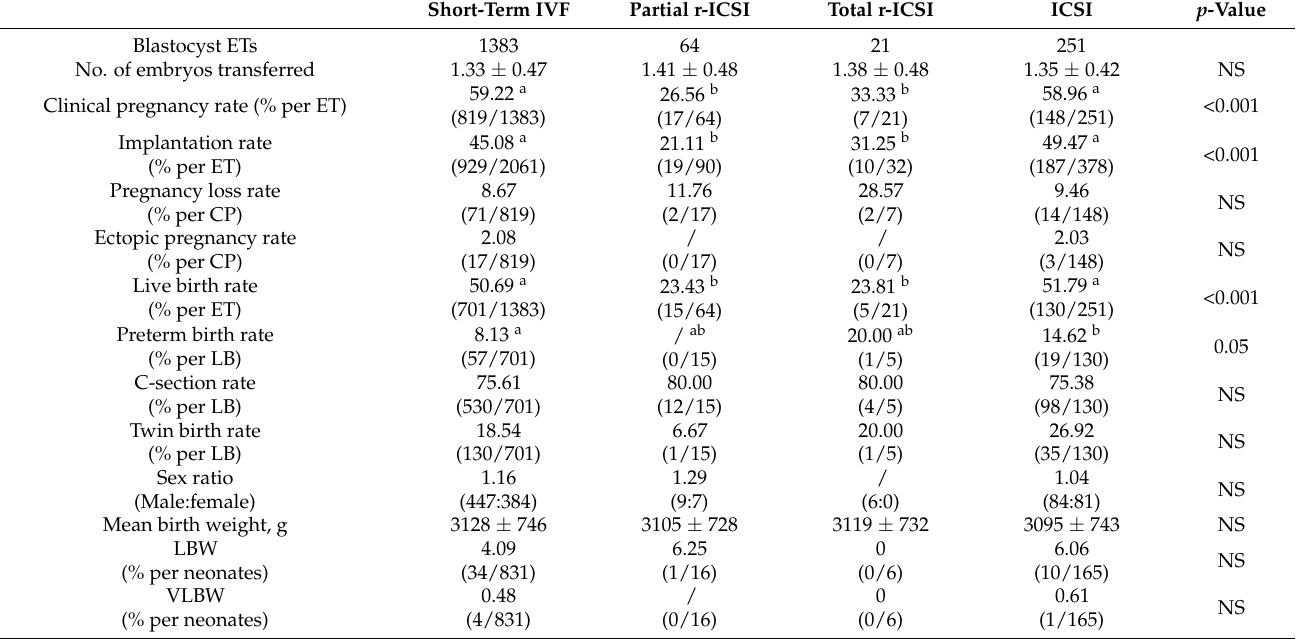
Table 4. Pregnancy, delivery, and neonatal outcomes among four groups in fresh blastocyst ET